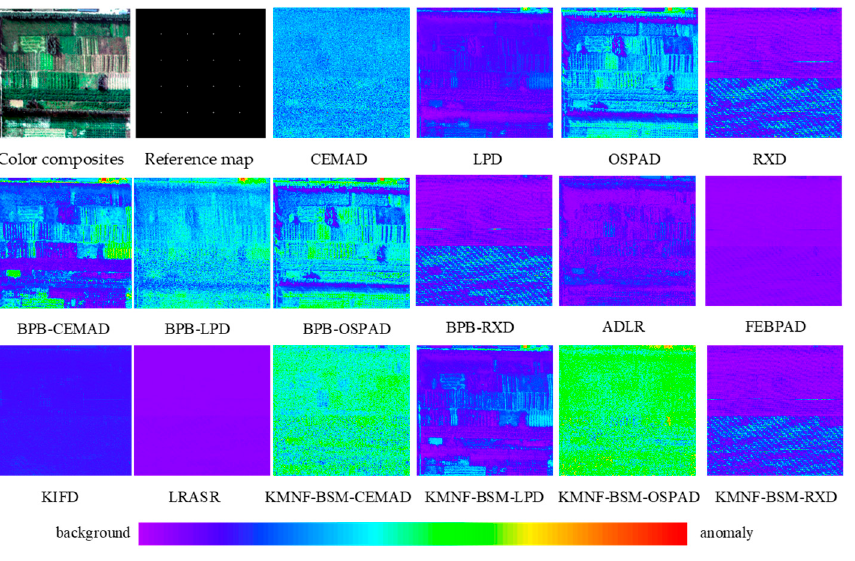
Figure 7. The detection maps of different detectors for the vegetation scene. In the detection maps of the vegetation scene in Figure 7, it can be seen that CEMAD, FEBPAD, KIFD, LRASR, KMNF-BSM-CEMAD, and KMNF-BSM-OSPAD have more uni- form backgrounds than other methods because the anomalous pixels occupy a tiny part of the entire image. The KMNF-BSM-RXD is relatively similar to RXD and BPB-RXD. To quantitatively assess the results, the 3D ROC curves along with their generated three 2D ROC curves of each method for different scenes are demonstrated in Figure 8, and the AUC values calculated from the three 2D ROC curves for HSI over the airport scene, the beach scene, the urban scene, and the vegetation scene are shown in Table 2.